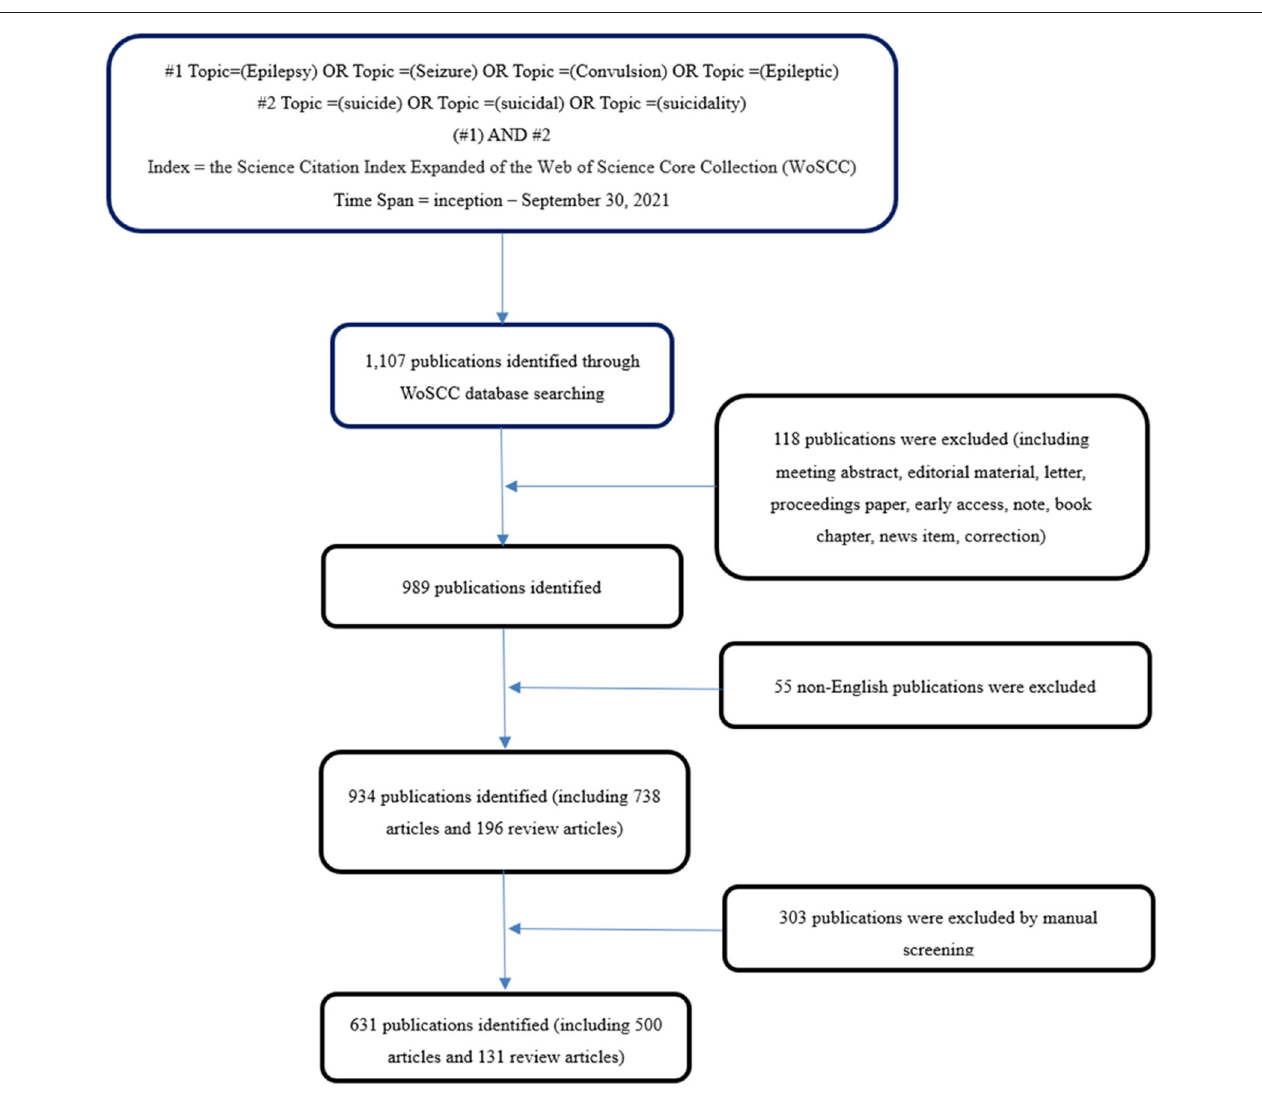
FIGURE 1 | Flow chart of literature screening included in this